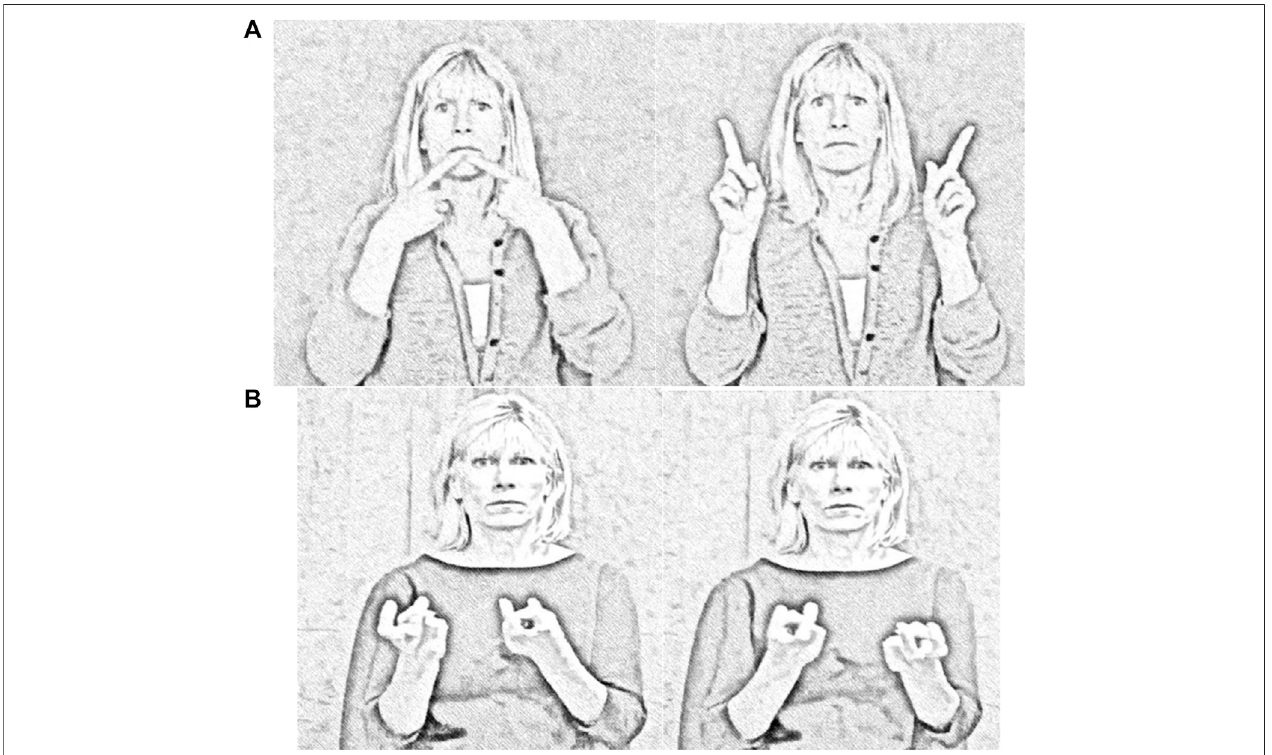
FIGURE 2 | ASL signs moving on the horizontal plane either in the opposite directions ( (A) , ANNOUNCE ) or in the same direction ( (B) , ROLLER-SKATING ). Examples are from the online dictionary ASL-Lex (Caselli et al. 2017).